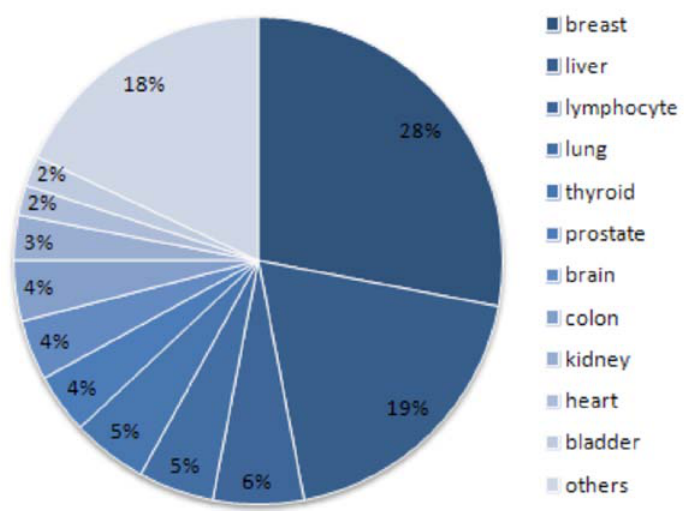
Figure 1: MSigDB cell context